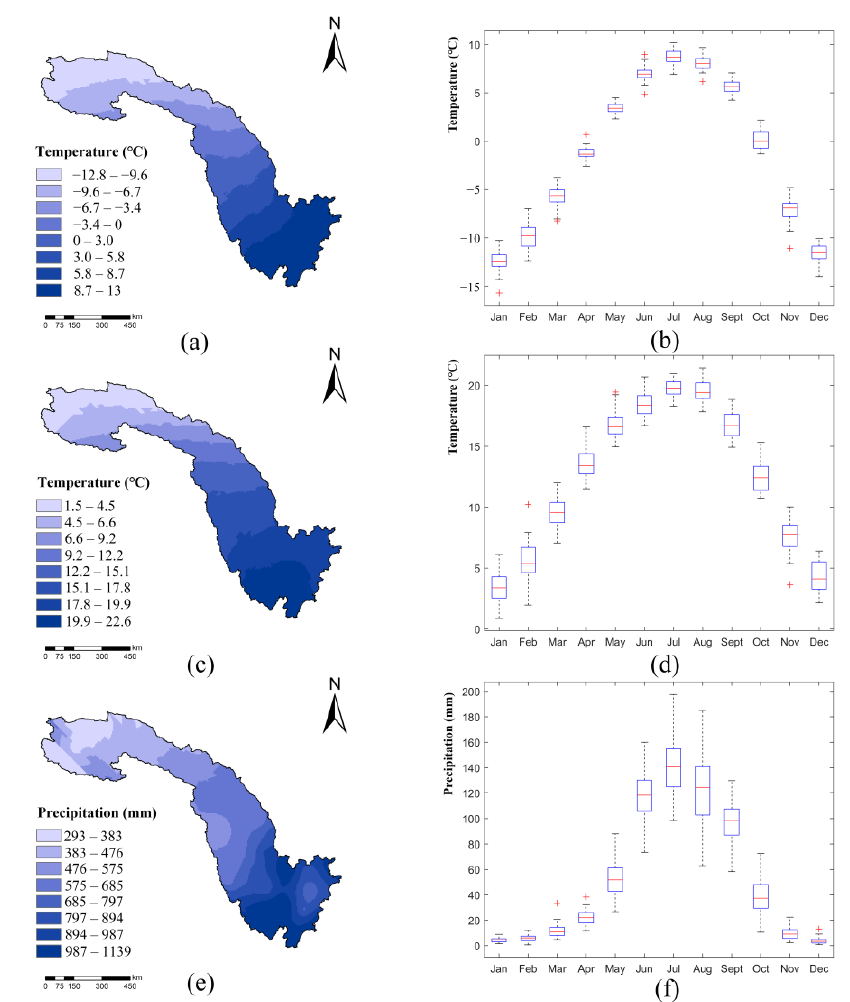
Figure 2. Spatial and temporal distributions of annual ( a , b ) T min , ( c , d ) T max , and ( e , f ) precipitation in the Jinsha River Basin (JRB).